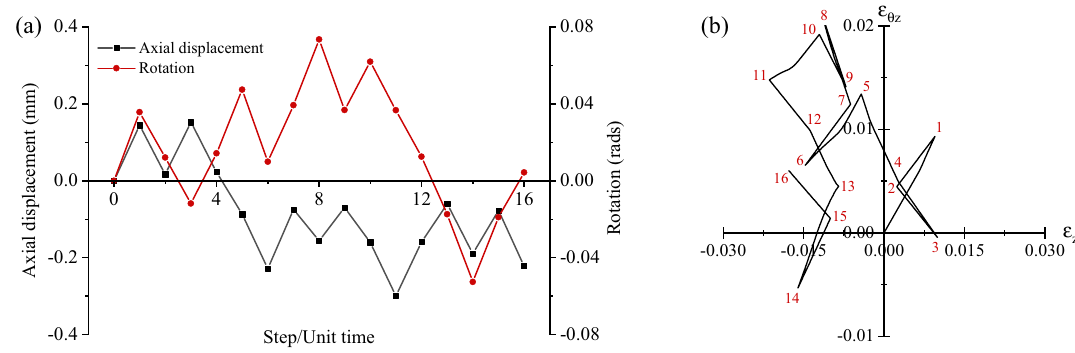
Figure 2. ( a ) Example of a 16-step history of imposed random displacement and rotation; ( b ) corresponding path in strain